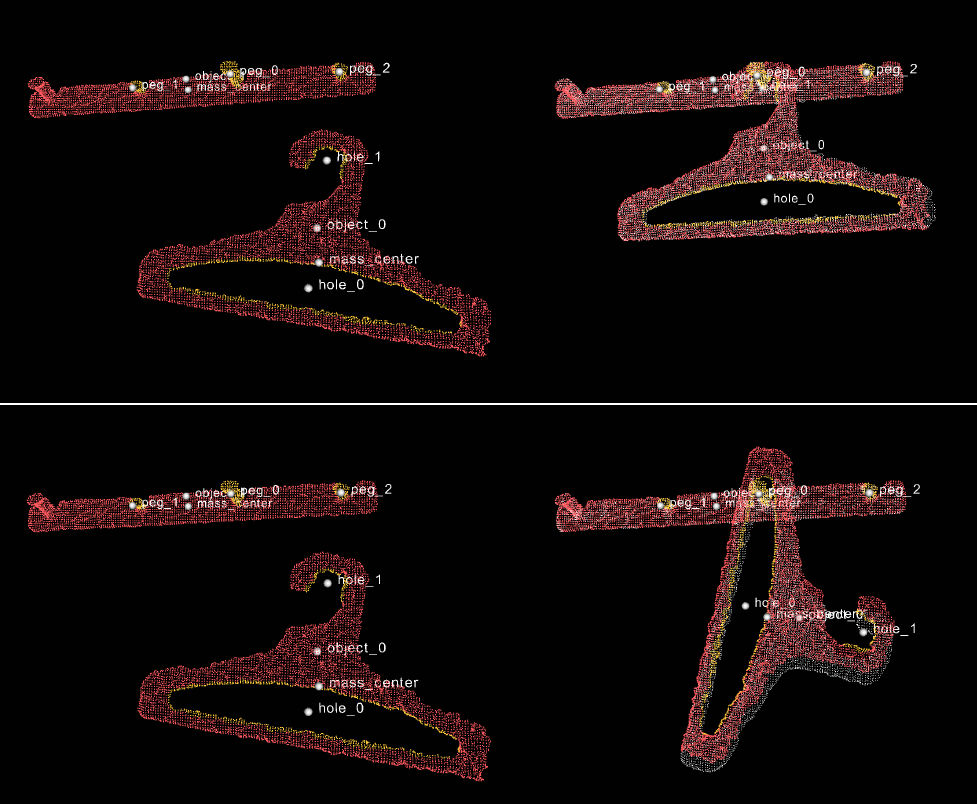
Figure 2. Two demonstrations, upper and lower , are input to the system. On the left are the point clouds representing scenes before the task execution. On the right are the point clouds representing scenes after the task execution. Whole objects are highlighted in red and detected object features are highlighted in